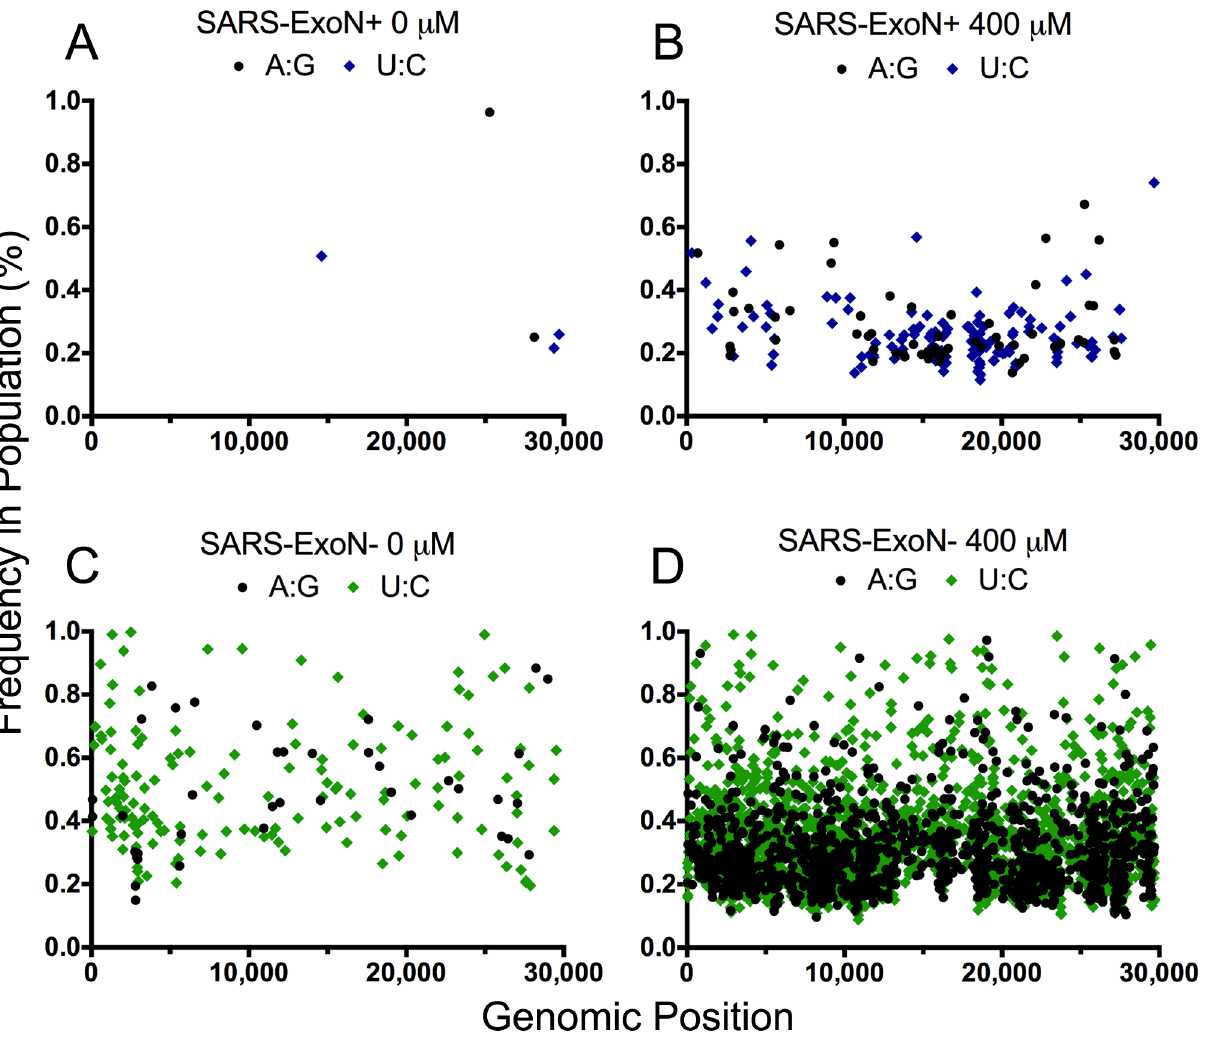
Figure 5. 5-FU-mediated U:C and A:G transitions are distributed across the CoV genome at low frequency. ( A ) and ( B ) The genomic distribution of low frequency statistically significant U:C and A:G variants within the SARS-ExoN + population following treatment with 0 or 400 m M 5- FU. ( C ) and ( D ) Same as in A and B except for the SARS-ExoN 2 population. For all panels, SARS-ExoN + viruses are shown in blue, and SARS-ExoN 2 viruses are shown in green. U:C transitions are denoted by a diamond, whereas A:G transitions are plotted as